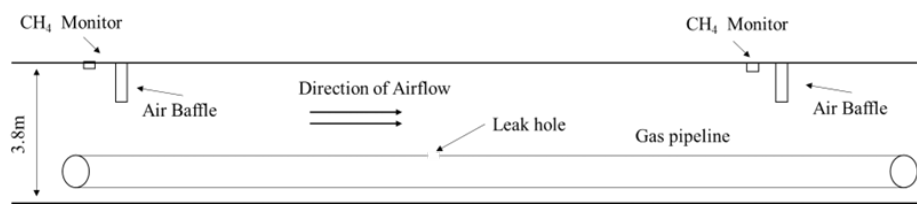
Figure 1. Two - dimensional simplified physical model of a gas leak. Figure 1. Two-dimensional simplified physical model of a gas